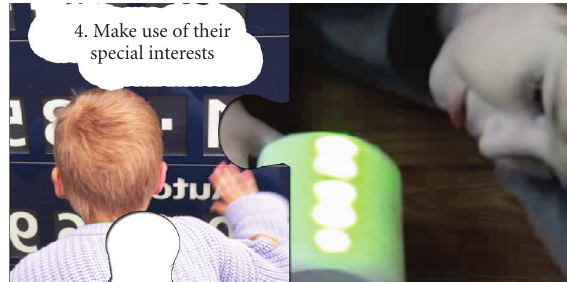
Figure 8: Special interests: (a) Beer’s special interest is numbers. They are everywhere and provide him a safe feeling. (b) Jakob’s special interest in colours encourages him to play with LINKX, although it hinders him from learning words.